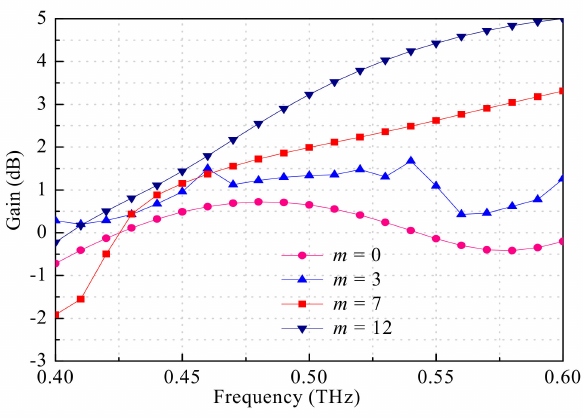
Figure 10. Simulated gains with di ff erent high impedance units.